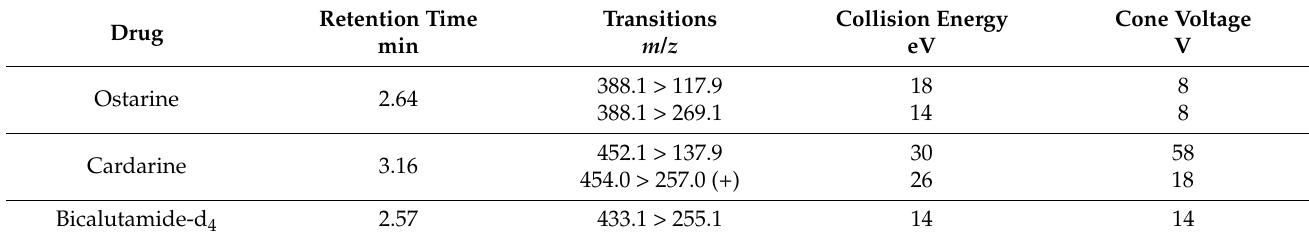
Table 1. Mass spectrometric and chromatographic data for the tested compounds.